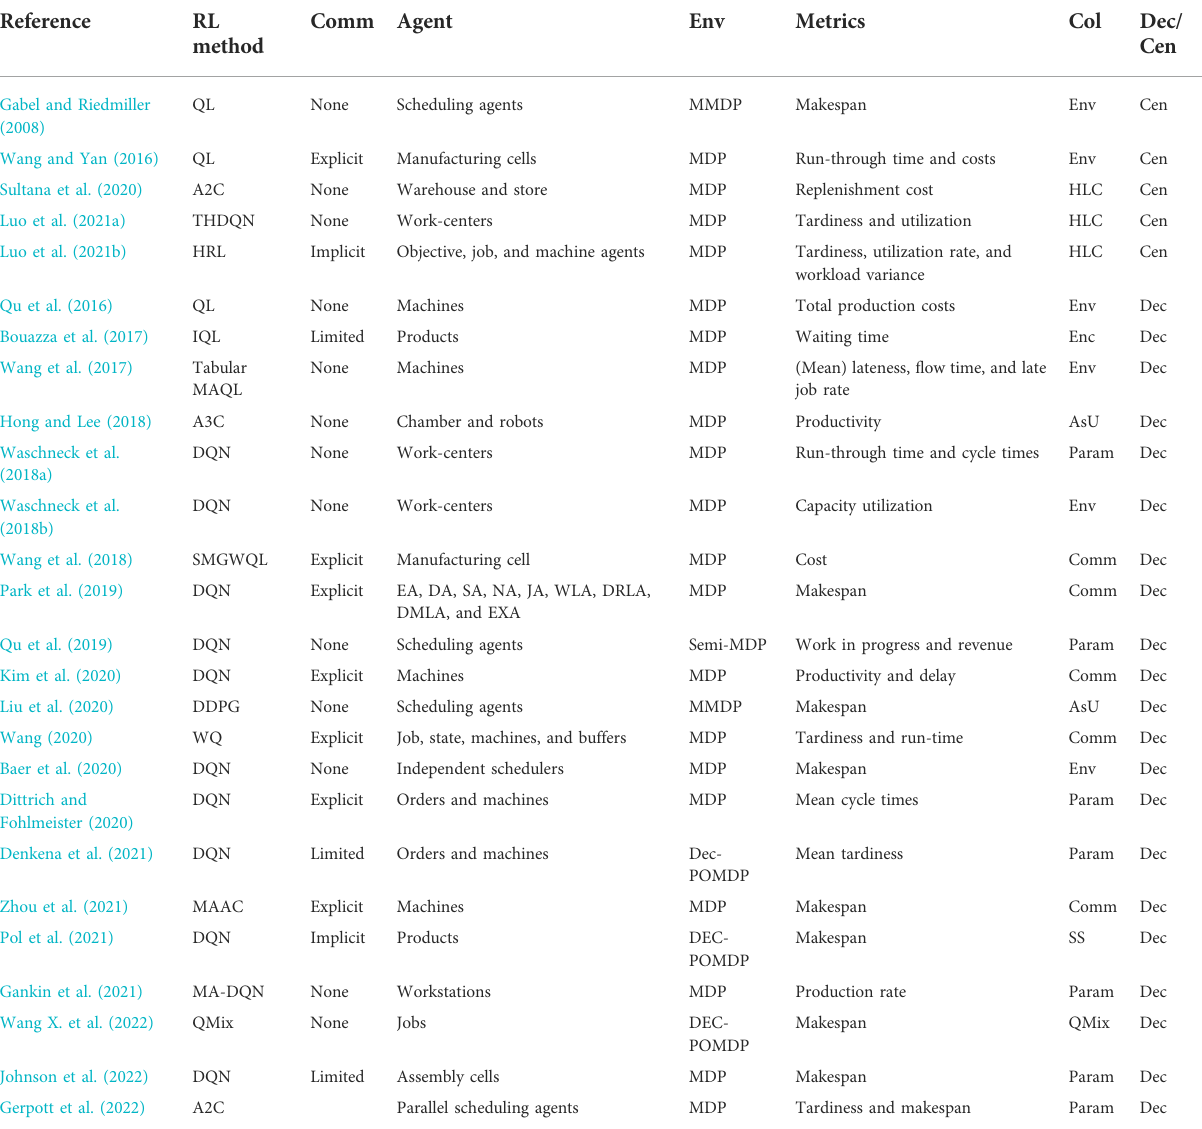
TABLE 1 Comparison between the MARL approaches incorporated for scheduling in smart